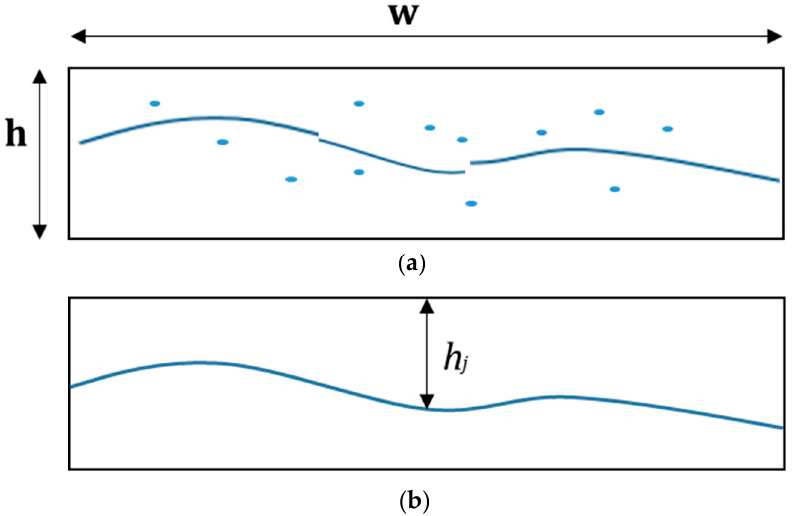
Figure 9. The gray gravity center method. ( a ) A box of the location sequence. The blue dots are the noise. In the box the extracted horizon is not continuous. ( b ) A box after calculating. h j represents the horizon location in each column in the box. After determining the horizon location, noise is eliminated and the horizon is continuous.